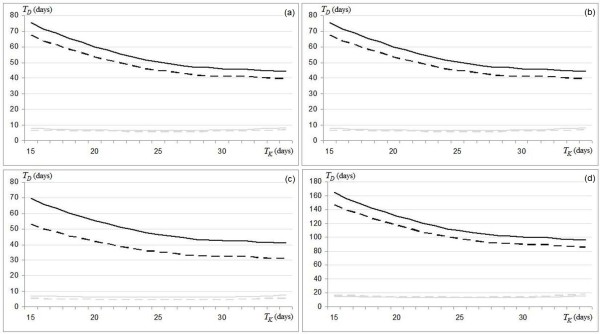
Curves of TDobtained by varying Tk, for HEGFr(black) and LEGFr(gray) groups based on the immunohistochemistry (continuous) and flow cytometry (dashed) methods to estimate the sub-sites iTpot. Differences are shown for Oral-Cavity (a), Oropharynx (b), Hypopharynx (c) and Larynx (d).